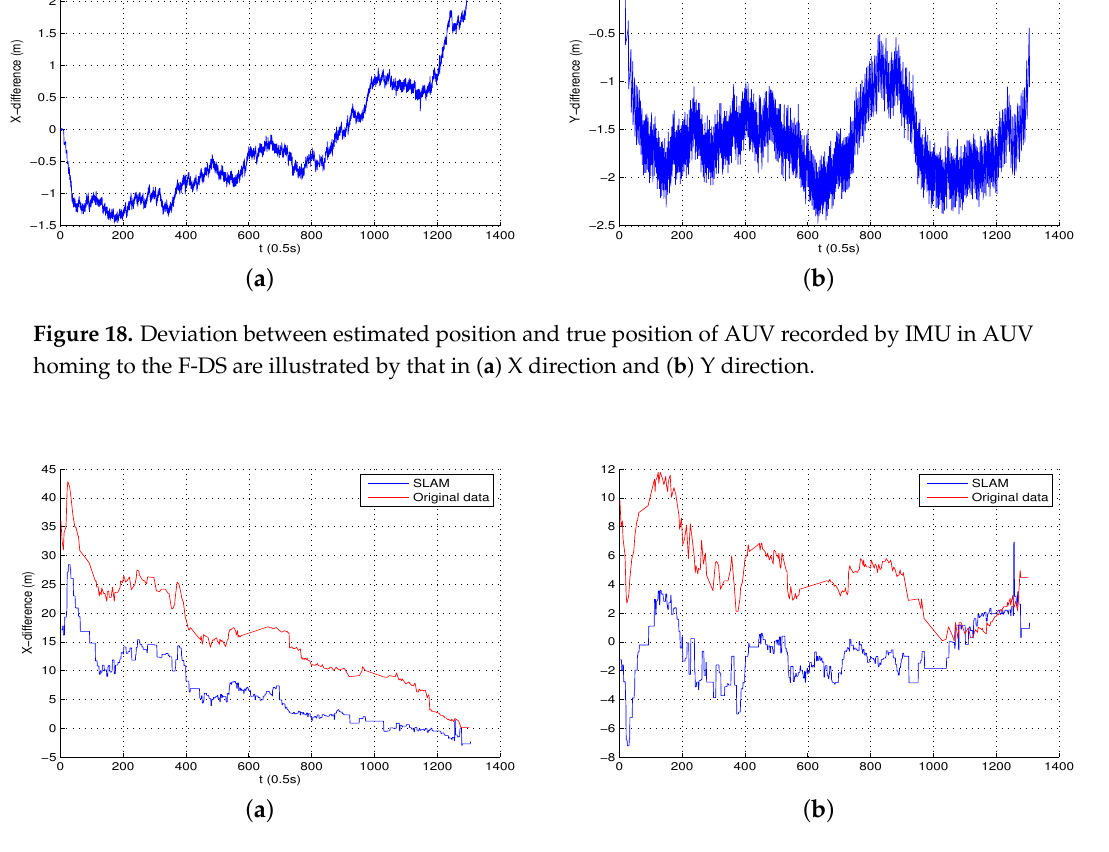
Figure 19. Deviation between estimated position and true position of F-DS recorded by IMU in AUV homing to the F-DS are illustrated by that in ( a ) X direction and ( b ) Y direction.